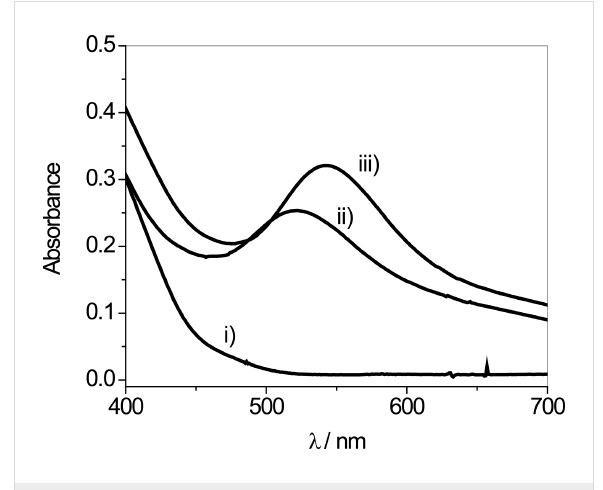
Figure 2: UV–vis spectra in glycerol: i) the HClAu 4 precursor; ii) the AuNPs synthesized with 8 min of irradiation time; iii) the AuNPs syn- thesized with 13 min of irradiation time ( λ irradiation = 300